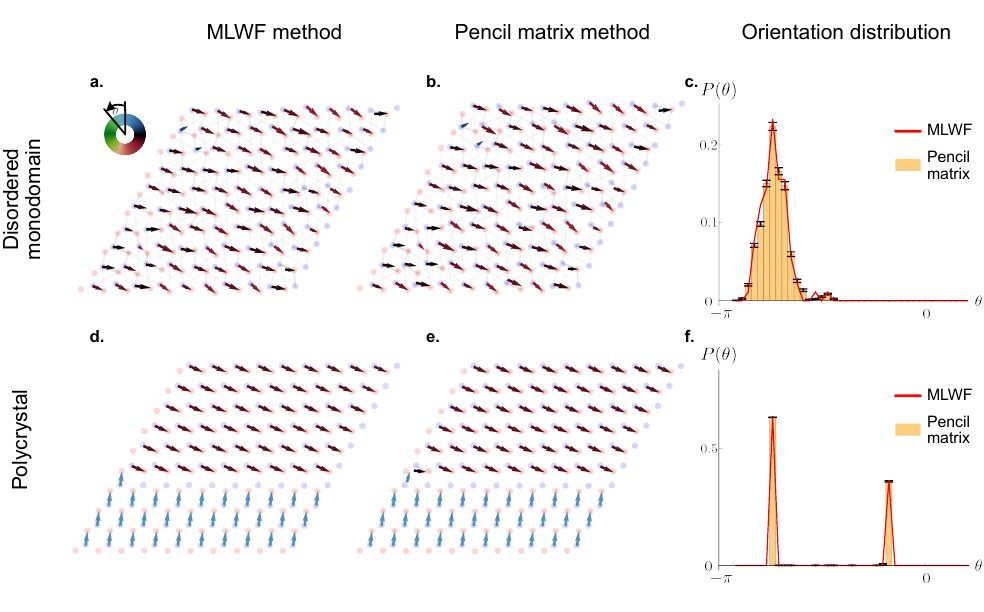
Figure 5: Pencil matrix versus maximally localized Wannier functions a. Single domain configuration with geometrical and spectral disorder. The chiral polarization field obtained from the maximally localized wannier functions is superposed. b. Chi- ral polarization field obtained from one realization of the pencil matrix procedure. c. Orientation distribution obtained from 50 values of α (bar chart), and from the maximally localized wannier functions (red solid line). d. , e. , f. correspond to the same information, this time for two crystalline